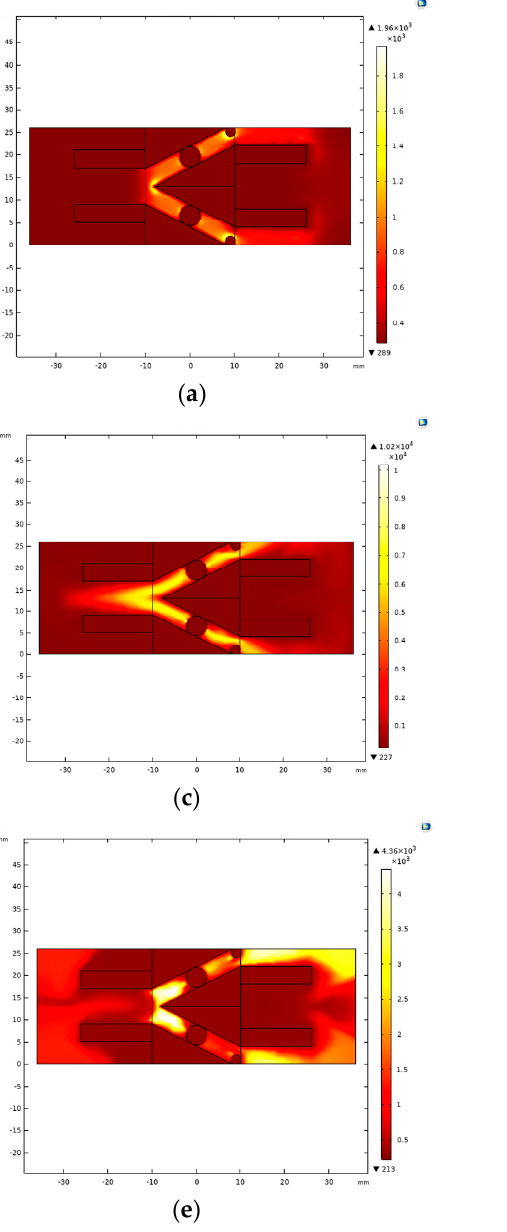
Figure 4. Map of the temperature distribution. ( a ) 0.02 ms, ( b ) 0.78 ms, ( c ) 1.35 ms, ( d ) 1.82 ms, ( e ) 2.15 ms, ( f ) 2.32 ms.